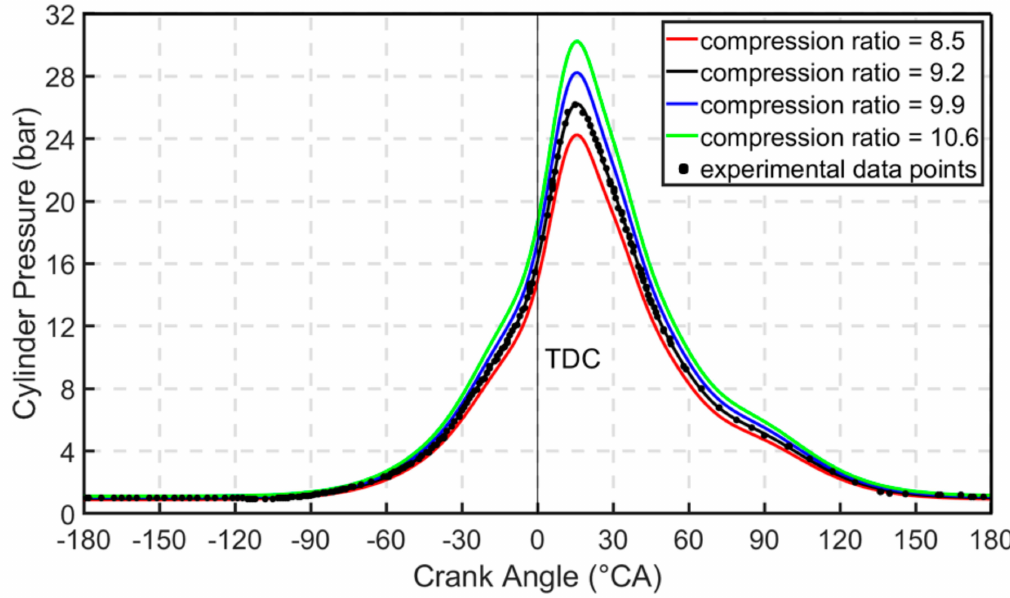
Figure A1. Comparison between cylinder curves with di ff erent compression ratios (medium load).